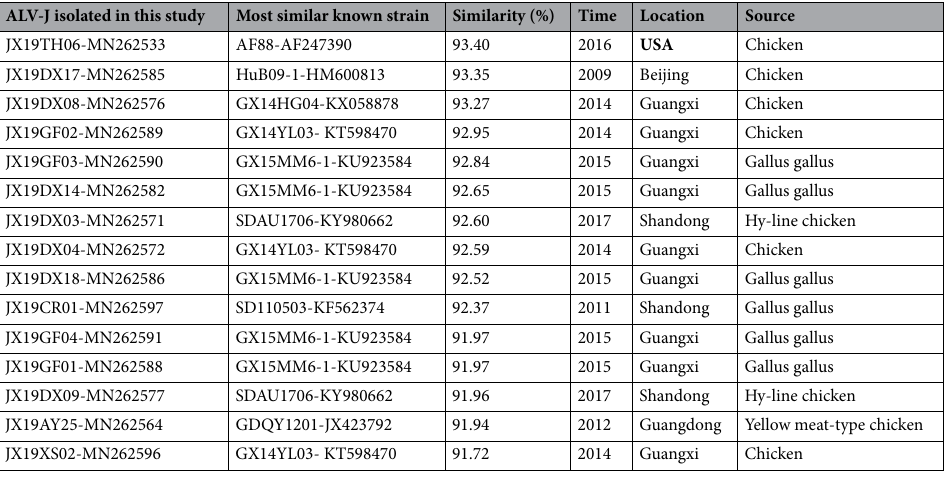
Table 2. ALV-J isolated in this study and one to one corresponding the most similar reference strain published in Genbank. The geographic location of the isolates in China is accurate to the provinces. The names of 13 strains that might replicate more slowly were